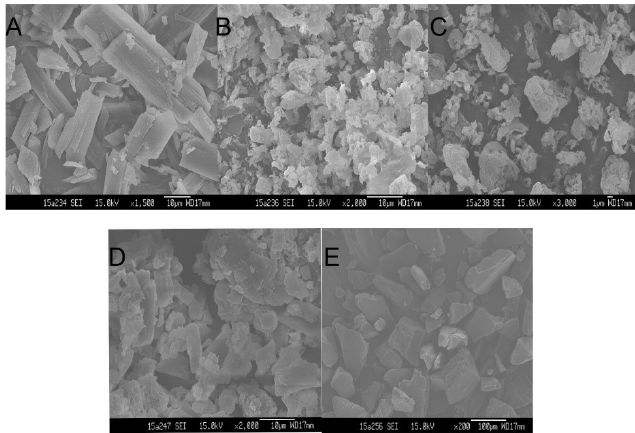
Figure 4. Scanning electron micrographs of ( A ) itraconazole (ITZ) powder, ( B ) Figure 4. Scanningelectronmicrographsof( A )itraconazole(ITZ)powder,( B )Hydroxypropylmethylcellulose Hydroxypropylmethylcellulose acetate succinate (HPMCAS), ( C ) D -α-tocopheryl polyethylene glycol acetate succinate (HPMCAS), ( C ) D - α -tocopheryl polyethylene glycol 1000 succinate (TPGS), ( D ) physical 1000 succinate (TPGS), ( D ) physical mixtures, ( E ) ITZ-HPMC AS-TPGS amorphous solid dispersion. mixtures, ( E ) ITZ-HPMC AS-TPGS amorphous solid